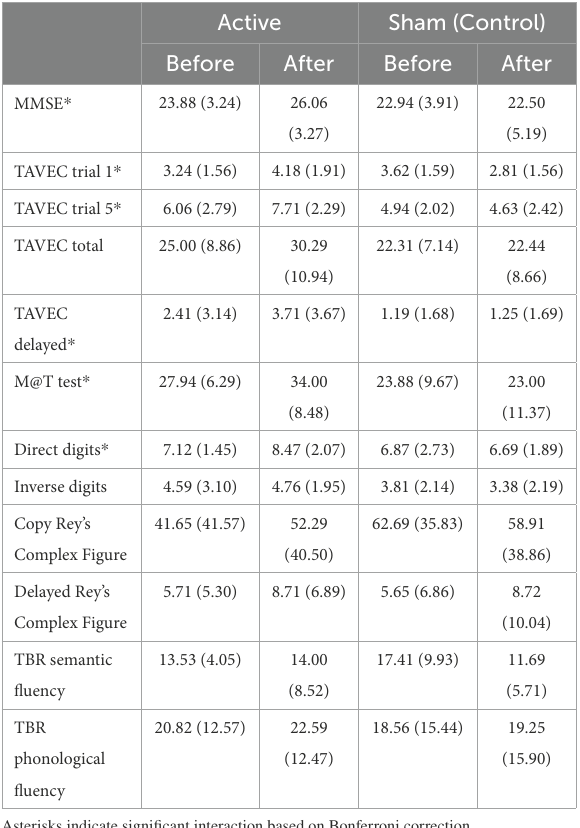
TABLE 3 Means (and SD) of the dependent variables as a function of groups (active vs. sham) and sessions (before vs. after intervention). Active Sham (Control) Before After Before